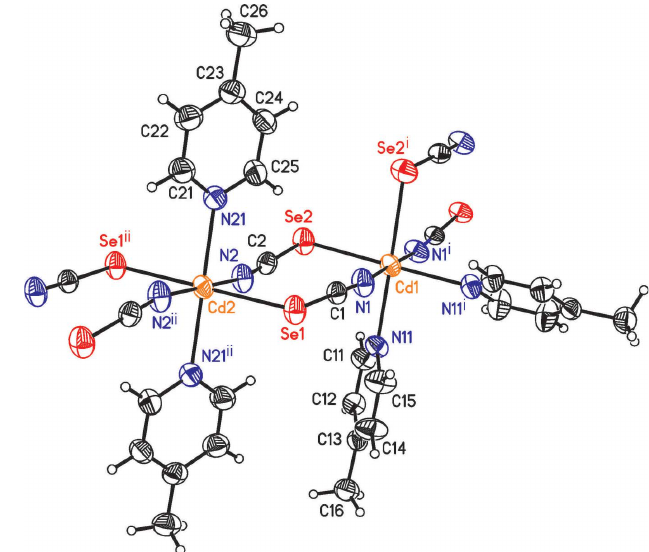
Figure 2 The coordination spheres of the two Cd cations in 2 with displacement ellipsoids drawn at the 50% probability level. Symmetry codes: (i) (cid:2) x + 1, y , (cid:2) z + 1 ; (ii) (cid:2) x + 3 , (cid:2) y + 1 , (cid:2) z + 2 2 2